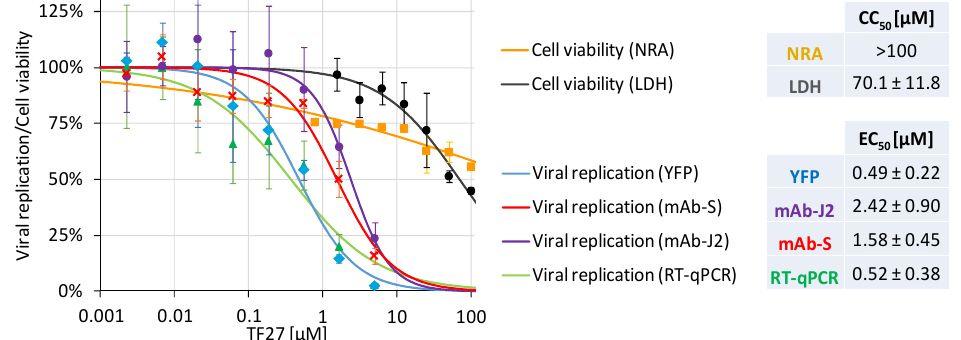
Figure 2. Anti-SARS-CoV-2 activity of TF27 analyzed by multiple parallel readouts. Human Caco-2 cells were infected with SARS-CoV-2 d6-YFP at the MOI of 0.003 and treated with the indicated concentrations of TF27. At 28 h p.i., cells were fixed using formalin and viral replication was determined by quantitation of the cell-associated YFP fluorescence (YFP), antibody stainings for viral dsRNA (mAb-J2) or the viral spike protein (mAb-S), and detection of released viral genomes using the cell culture supernatant (RT-qPCR). Cell viability was measured in parallel cultures of uninfected Caco-2 cells after 48 h of treatment by Neutral Red assay (NRA) as well as lactate dehydrogenase release assay (LDH). The values represent means ± SD of the biological quadruplicates (replication) or triplicates (NRA and